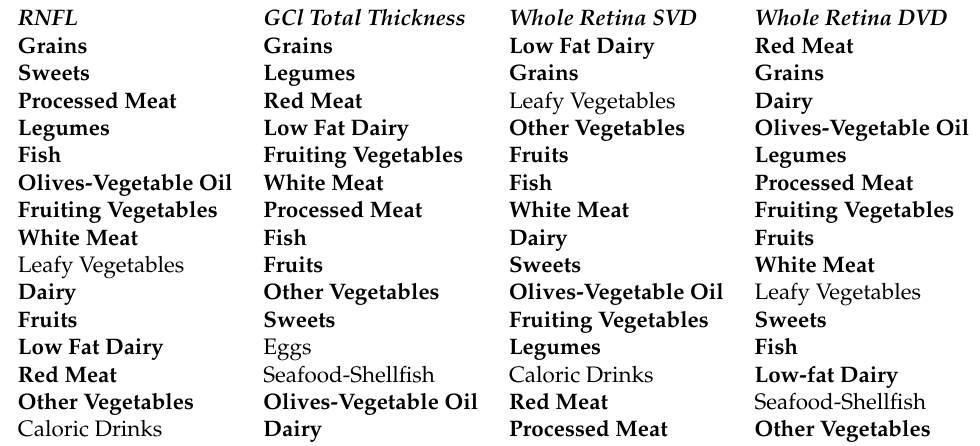
Table 3. Summary of dietary pattern predictors of retinal